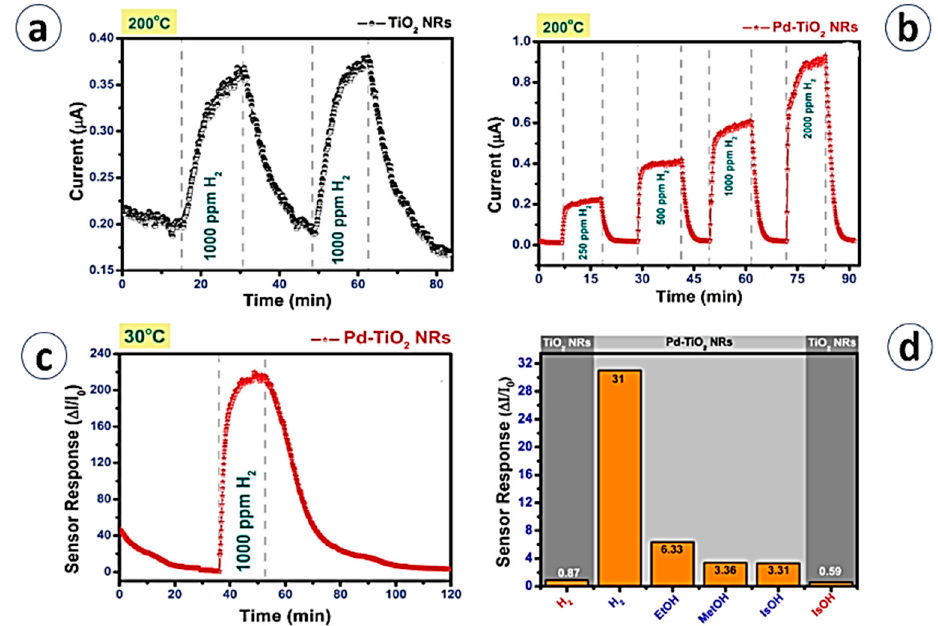
Figure 9. ( a ) Dynamic response of TiO 2 nanorods at 200 ◦ C. ( b ) Dynamic response of Pd-TiO 2 at 200 ◦ C toward di ff erent H 2 concentrations. ( c ) Dynamic response of Pd-TiO 2 at 30 ◦ C toward 100 ppm of H 2 ( d ) Sensor responses of TiO 2 and Pd TiO 2 nanorod device for H 2 and VOCs at 200 ◦ C. Reprinted with permission from Ref. [75] Copyright 2016 Elsevier.